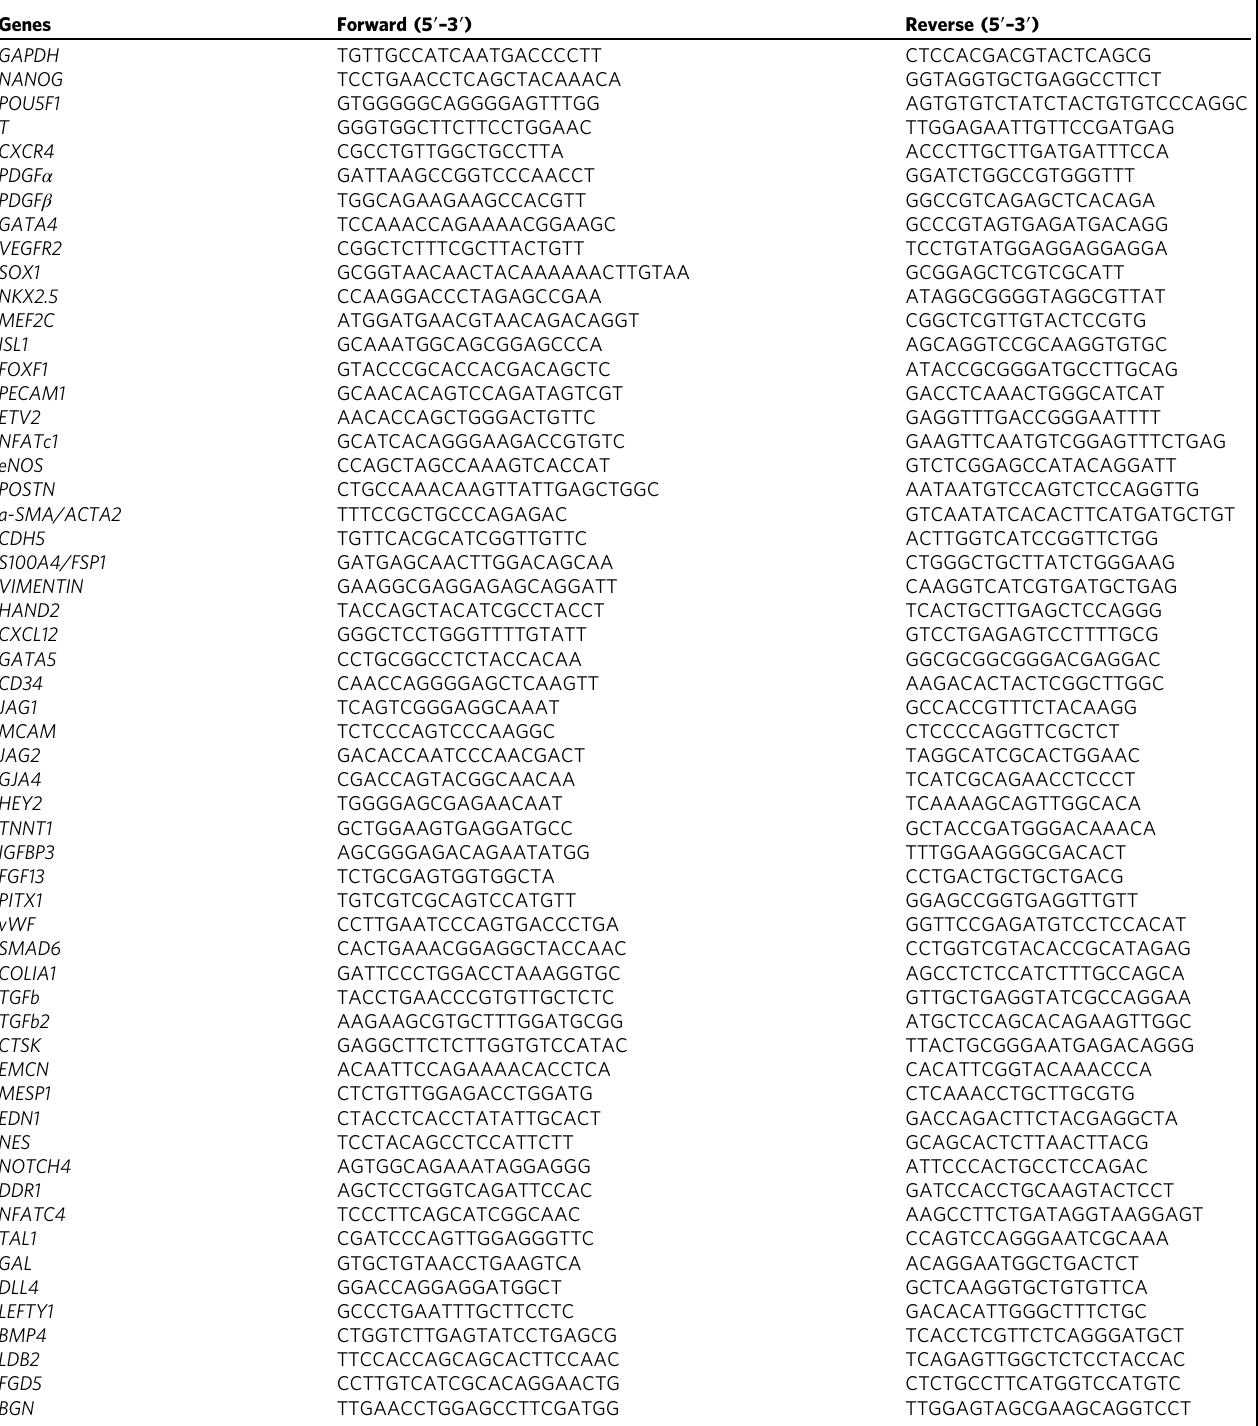
Table 2 The primers used for qRT-PCR analysis.